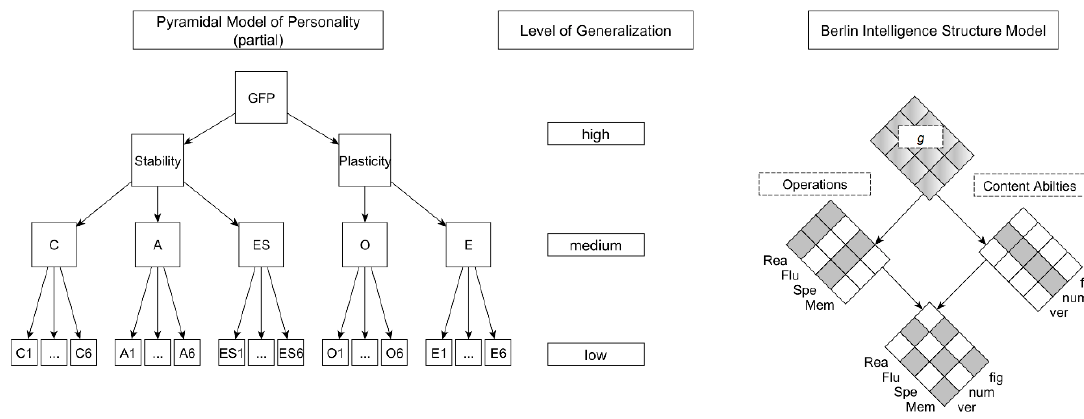
Figure 2. Illustration of the hierarchical levels. GFP = general factor of personality, C = Conscientiousness, A = Agreeableness, ES = Emotional Stability, O = Openness, E = Extraversion, Numbers = facets of the corresponding dimensions, Rea = reasoning, Flu = fluency, Spe = perceptual speed, Mem = short-term memory, ver = verbal, num = numerical, fig = figural. The lowest level (i.e., items and specific responses) of the Pyramidal Model of Personality [4,5] are not